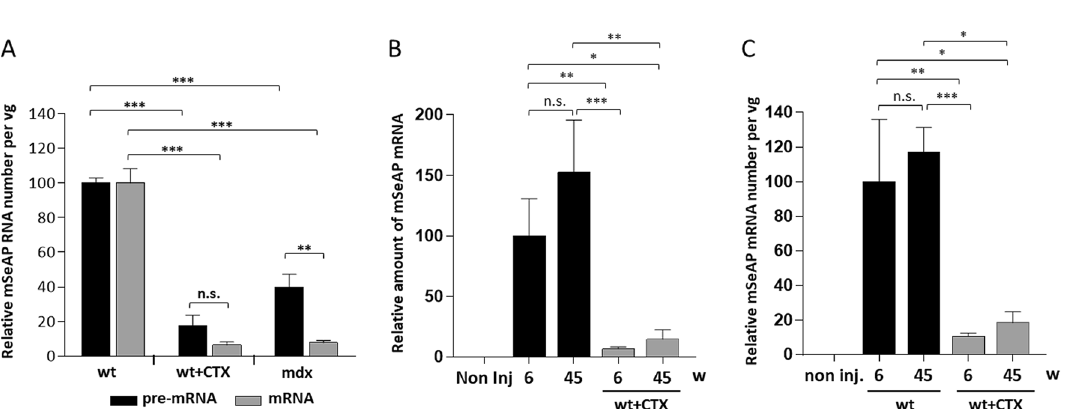
Figure 4. Evaluation of AAV1-mSeAP expression after muscle regeneration. ( A ) Quantification of mSeAP pre-messengers (pre-mRNA) and transcripts (mRNA) 6 weeks after CTX injury and 3 week after AAV-mSeAP injection performed by relative qPCR and normalised by the AAV genome numbers. Relative RNA number is expressed as a percentage of wt RNAs. ( B ) Quantification of mSeAP mRNA at 6 and 45 weeks post-injury by relative qPCR and expressed as a percentage of mSeAP transcripts present in wt muscles (6w). Non inj., wt non-AAV injected TA. ( C ) Quantification of mSeAP transcripts normalised by the AAV genome numbers in the corresponding muscles. Relative RNA number is expressed as a percentage of wt transcripts (6w). The data represent the mean values of minimum four TAs per group ± SEM. N.s. non-significant, * P ≤ 0.05, ** P ≤ 0.01, *** P ≤